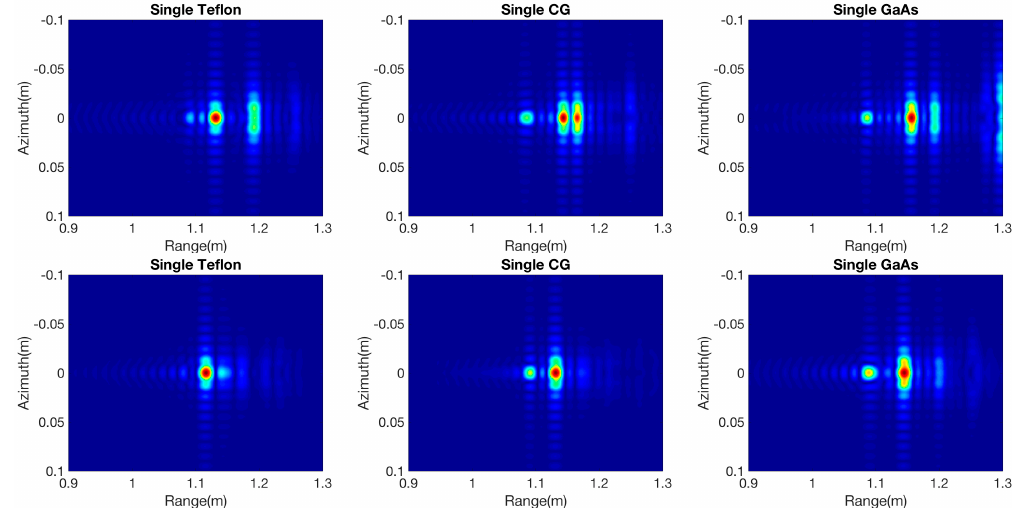
Figure 14. Image of a single dielectric sphere for the monostatic versus bistatic ( left : Teflon; center : ceramic glaze; right : GaAs). ( top row : monostatic; bottom row : bistatic).